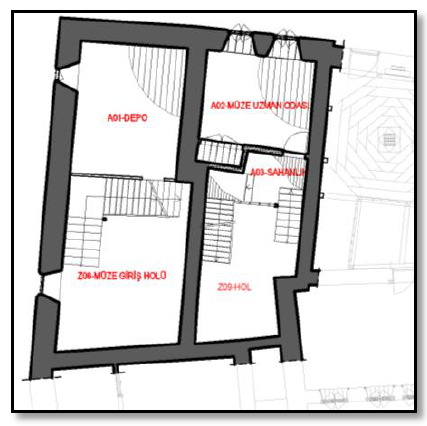
Figure 13. Restoration Project- Spaces of Museum